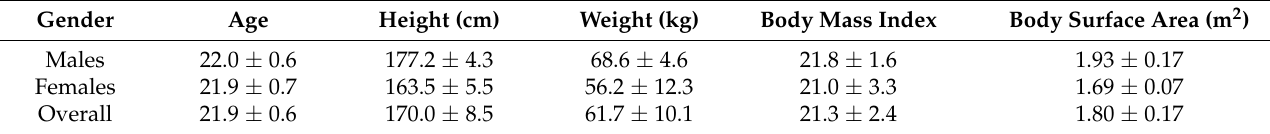
Table 2. Anthropometric information of participants.